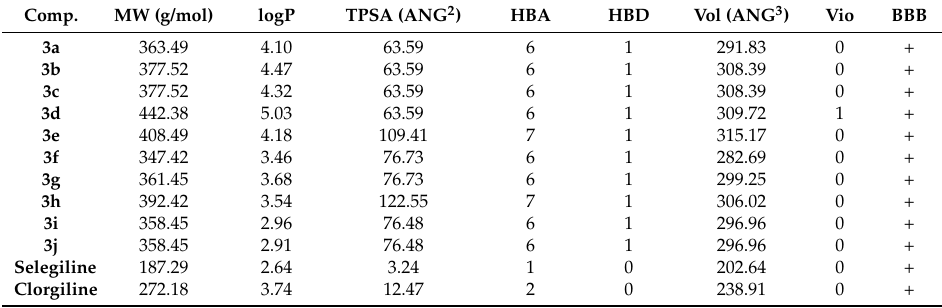
Table 4. Some physicochemical parameters of the compounds 3a – 3j and reference drugs used in the prediction of ADME